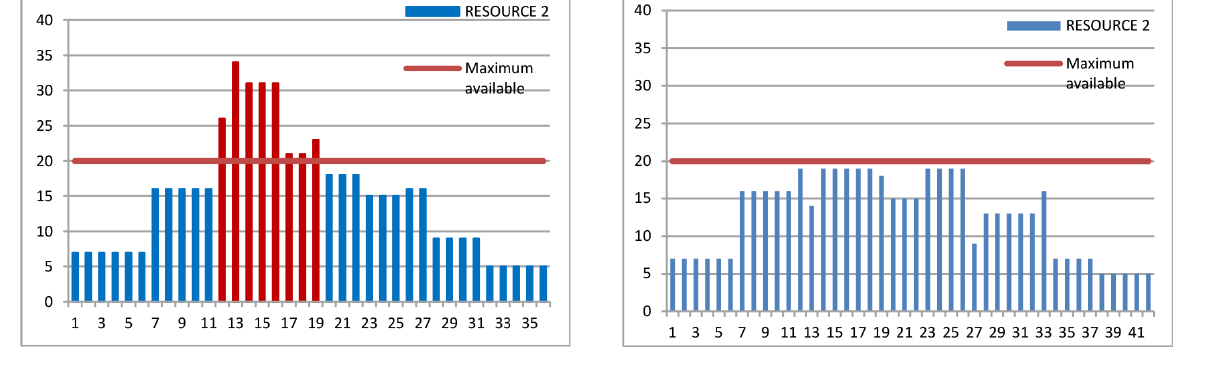
Figure 19. Daily usage of resource 2 throughout the calendar of the project (before using the method)-Experiment 1